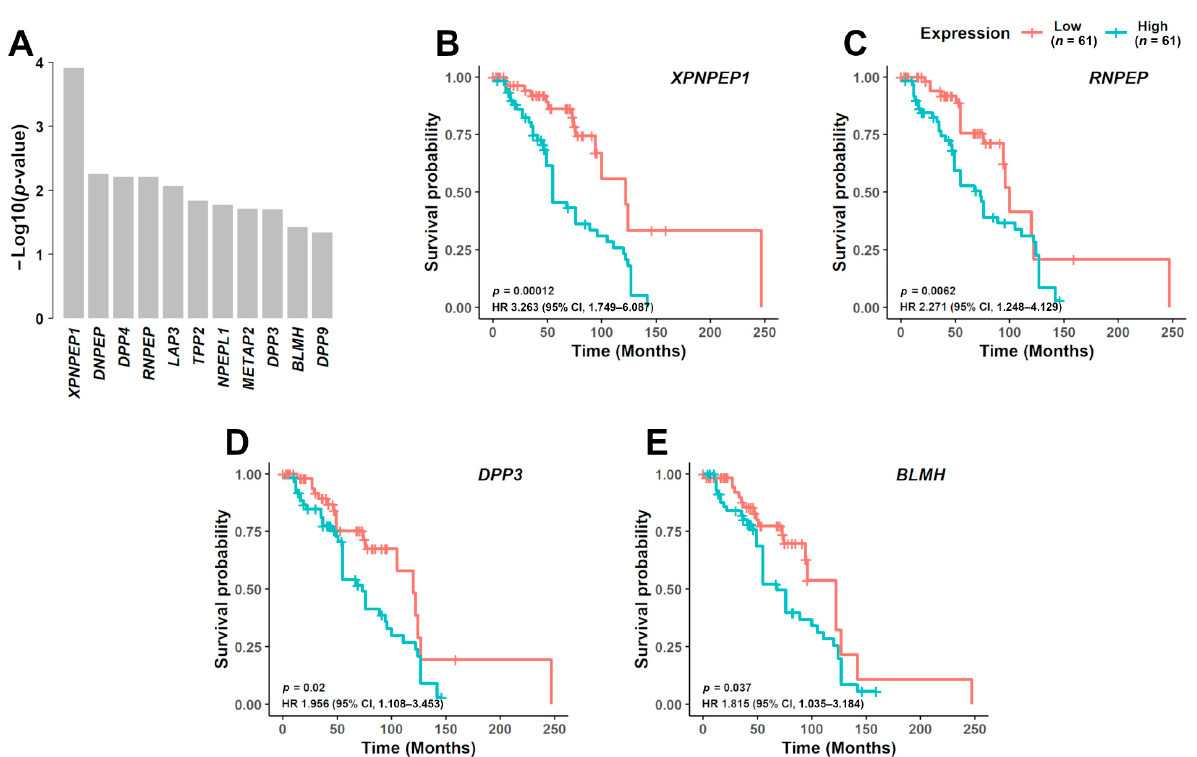
Figure 3. Prognostic significance of aminopeptidase gene expression in MM. ( A ) In the FIMM dataset consisting of 122 MM samples, NDMM ( n = 41) and RRMM ( n = 81), from 99 different patients, 11 aminopeptidase genes were predicted to be associated with poor prognosis ( p < 0.05). From these 11 genes, 4 were further validated in the CoMMpass dataset. Survival curves are shown for the 4 aminopeptidase genes based on the FIMM dataset, dividing the patients with low gene expression ( n = 61) and high gene expression ( n = 61): ( B ) XPNPEP1 , ( C ) RNPEP , ( D ) DPP3 , and ( E ) BLMH . NDMM: newly diagnosed multiple myeloma; RRMM: relapsed/refractory multiple myeloma; HR: hazard ratio; CI: confidence interval.